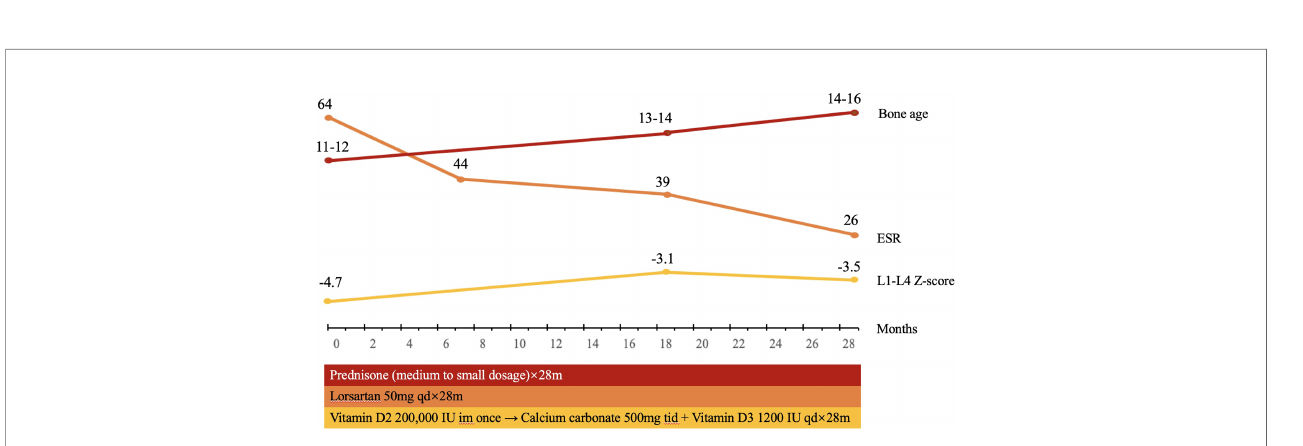
FIGURE 2 | The timeline of treatment for the patient with CED. The patient was treated with prednisone, initiated at 30mg/day, decreased to 10 mg/day in 20 days, and then adjusted between 5 and 15 mg/day. Losartan 50 mg/day was given to the patient together with prednisone. Vitamin D2 of 200,000 IU intramuscular injection was given once, continued with calcium carbonate of 500 mg tid and vitamin D3 1200 IU qd. During the follow-up for 28 months, the BMD in L1 – L4 in the patient signi fi cantly increased. Bone age increased from 11 – 12 years to 14 – 16 years, and Tanner stage of pubic hair and breast of the patient increased from stage 1 to 3 and from stage 1 to 4, which indicated that puberty was initiated and